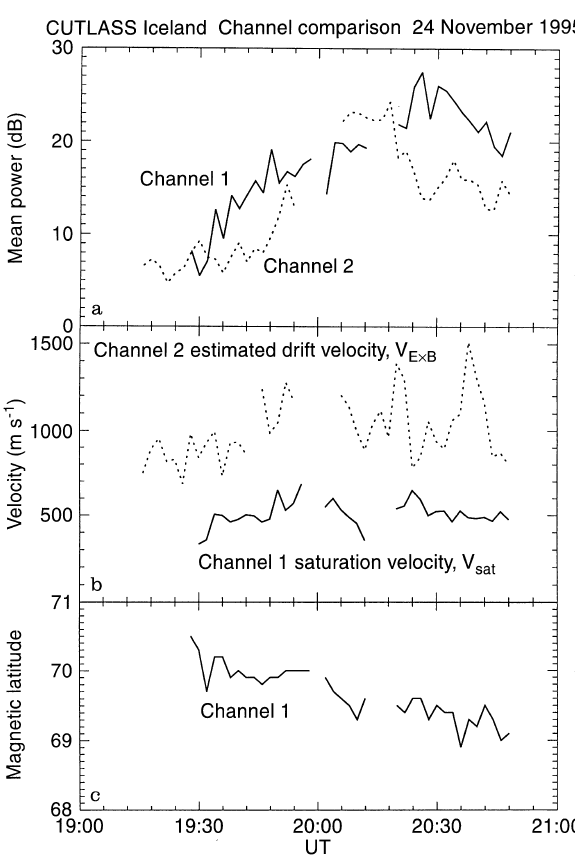
Fig. 7a–c. A comparison of time-series of backscatter characteristics from channels 1 ( solid lines ) and 2 ( dotted lines ) between 1915 and 2045 UT, 24 November 1995. a Mean backscatter power along each channel. b Estimated channel 2 plasma drift velocity, V E (cid:2) B , and the saturation velocity of channel 1, V sat . c The geomagnetic latitude of